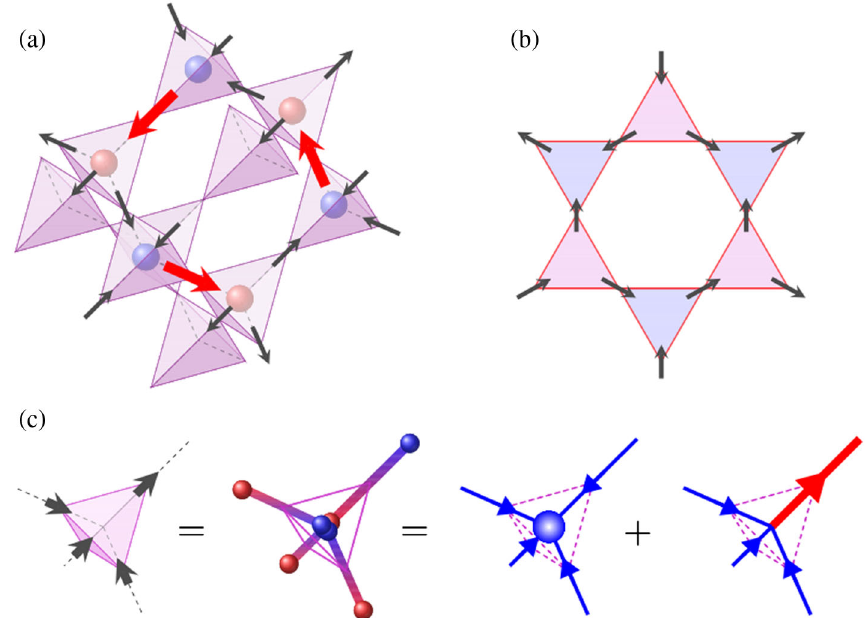
FIG. 1. Lattice structures: (a) Pyrochlore lattice, showing monopole-crystal and magnetic needle (spin) orientations. The sublattice index (cid:1) i defined in Eq. (4) is þ 1 (respectively, (cid:2) 1 ) on the diamond sites where the blue (respectively, red) monopoles sit. The minority spins (red arrows) are equivalent to dimers positioned on the diamond lattice. (b) Two-in–one-out spin configurations in the confined KII kagome spin-ice phase. (c) Spin and needle configurations for a three-in–one-out vertex carrying an isolated north pole showing magnetic- moment fractionalization into divergence-full and divergence-free elements. We emphasize that the divergence-free field emerging here, despite being a Coulomb phase, is different from the standard one in the absence of monopoles described in Ref.